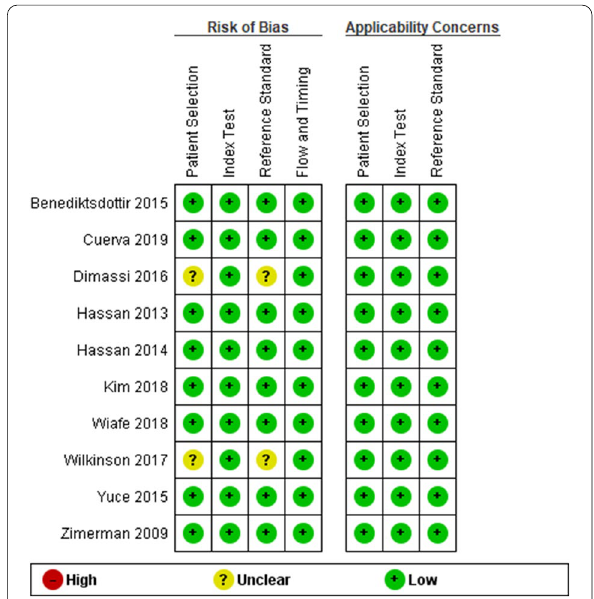
Fig. 2 Risk of bias and applicability concerns summary: review authors’ judgments about each domain for each included